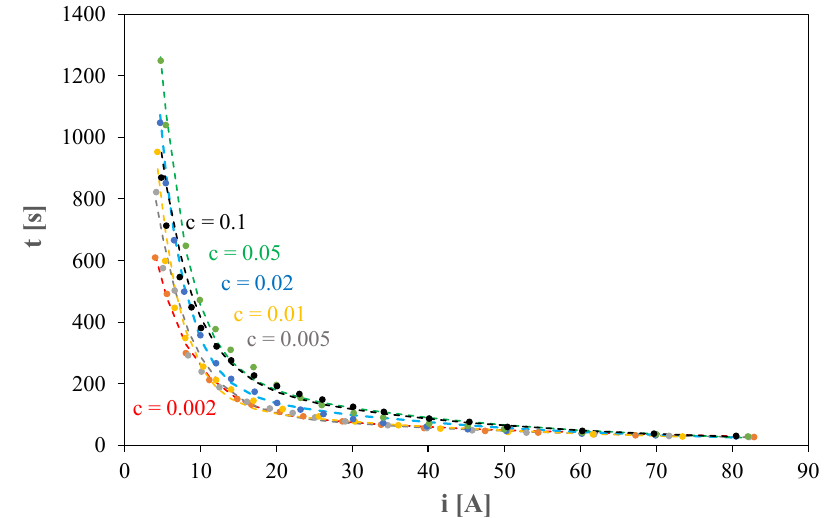
Figure 5. Calculated and measured dependence of time t on the electrolyzer supply current.